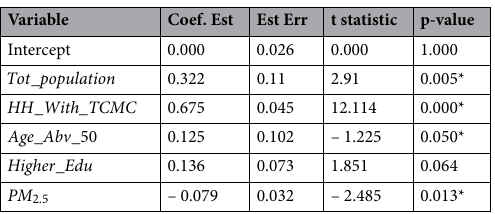
Table 4. Summary of the global model (OLS) for various socioeconomic, demographic, and environmental pollution related factors. *Significant at 0.05.